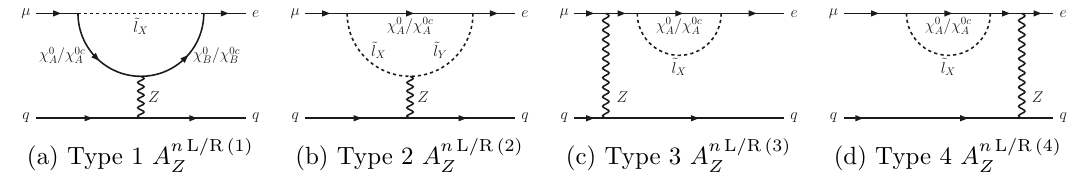
Figure 2. The four types of Z -penguin diagrams corresponding to eqs. (3.34). The chargino diagrams are analogous with the replacement of (cid:31) 0 with (cid:31) (cid:0) and ~ l with ~ (cid:23) . 0 : 0169 in units of m 5 = 2 (cid:22) . The capture rate for aluminium is ! capt = 0 : 7054 4 : 643 10 (cid:0) 19 GeV [82, (cid:2)